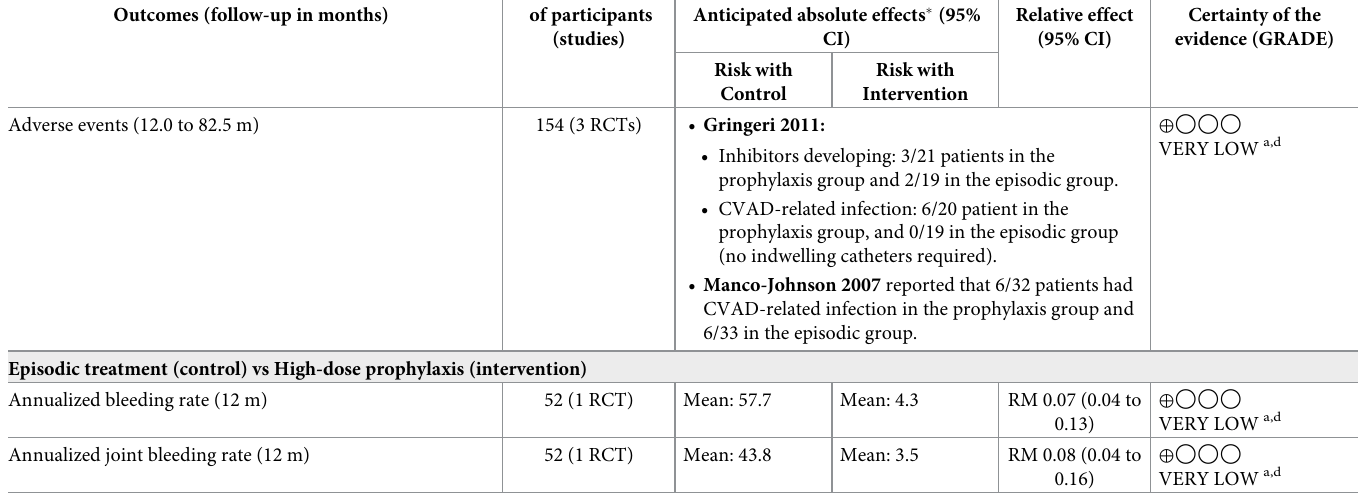
(test for subgroup differences: p = 0.003, I 2 = 82.9%) (Fig 3A). These results had a very low cer- tainty of evidence (Table 2).